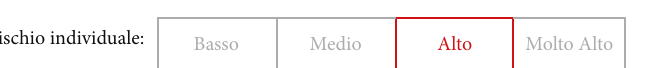
Figure 7: Genetic test